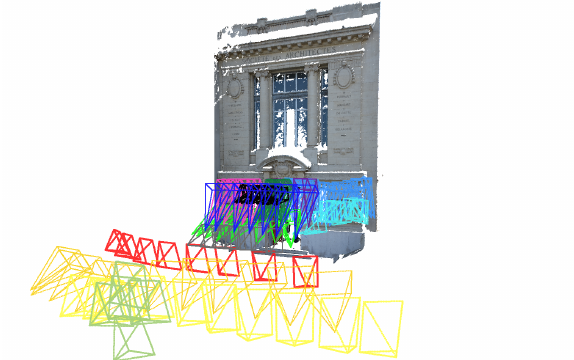
Figure 7: Example of complex multi-focal processing (each color represent an iteration) on Facade dataset